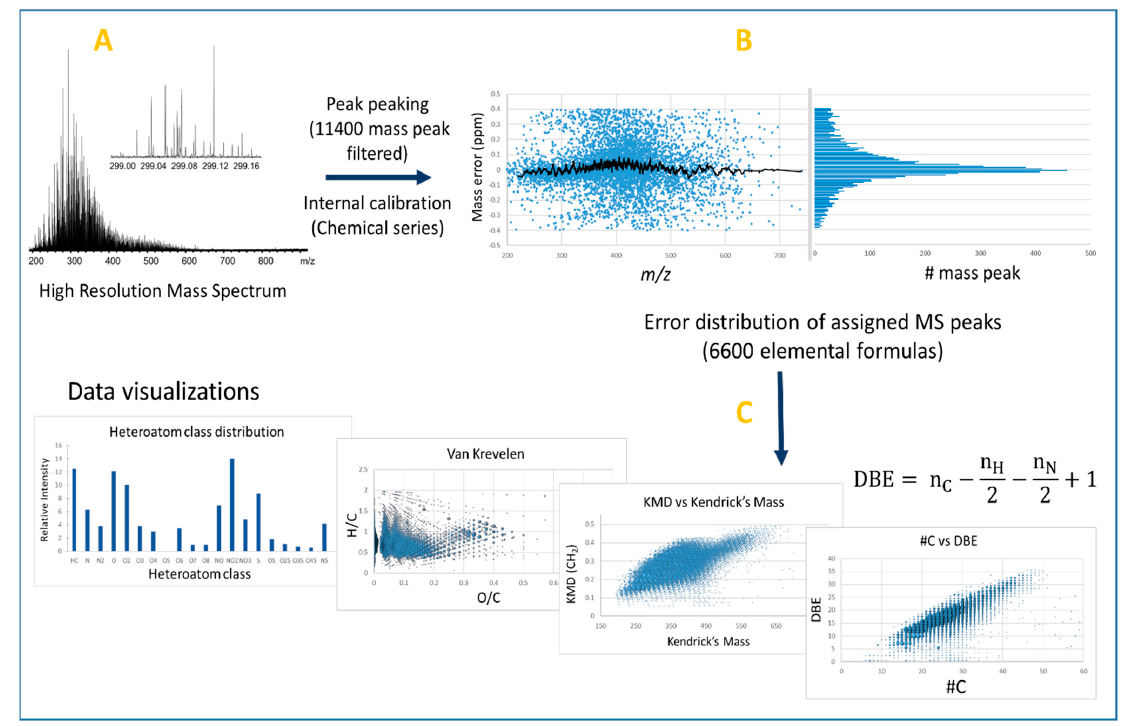
Figure 1. Typical petroleomic workflow: ( A ) acquisition of mass spectrum in high resolution mode (here LDI of coal-type sample); ( B ) distribution of mass measurement errors of assigned peaks after internal calibration of HR mass spectrum—the histogram is used to verify the normality of the error distribution; and ( C ) description of sample composition by various visualization tools.